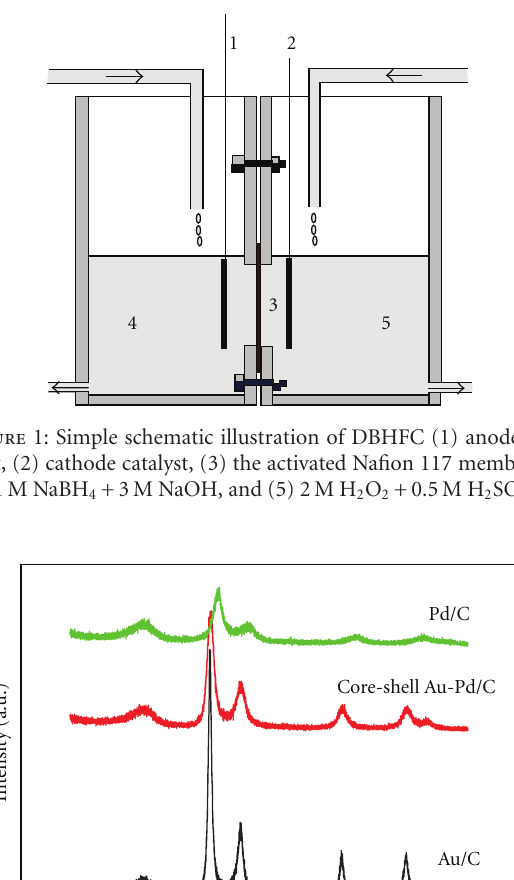
Figure 1, and it consisted of Au/C cathode, core-shell